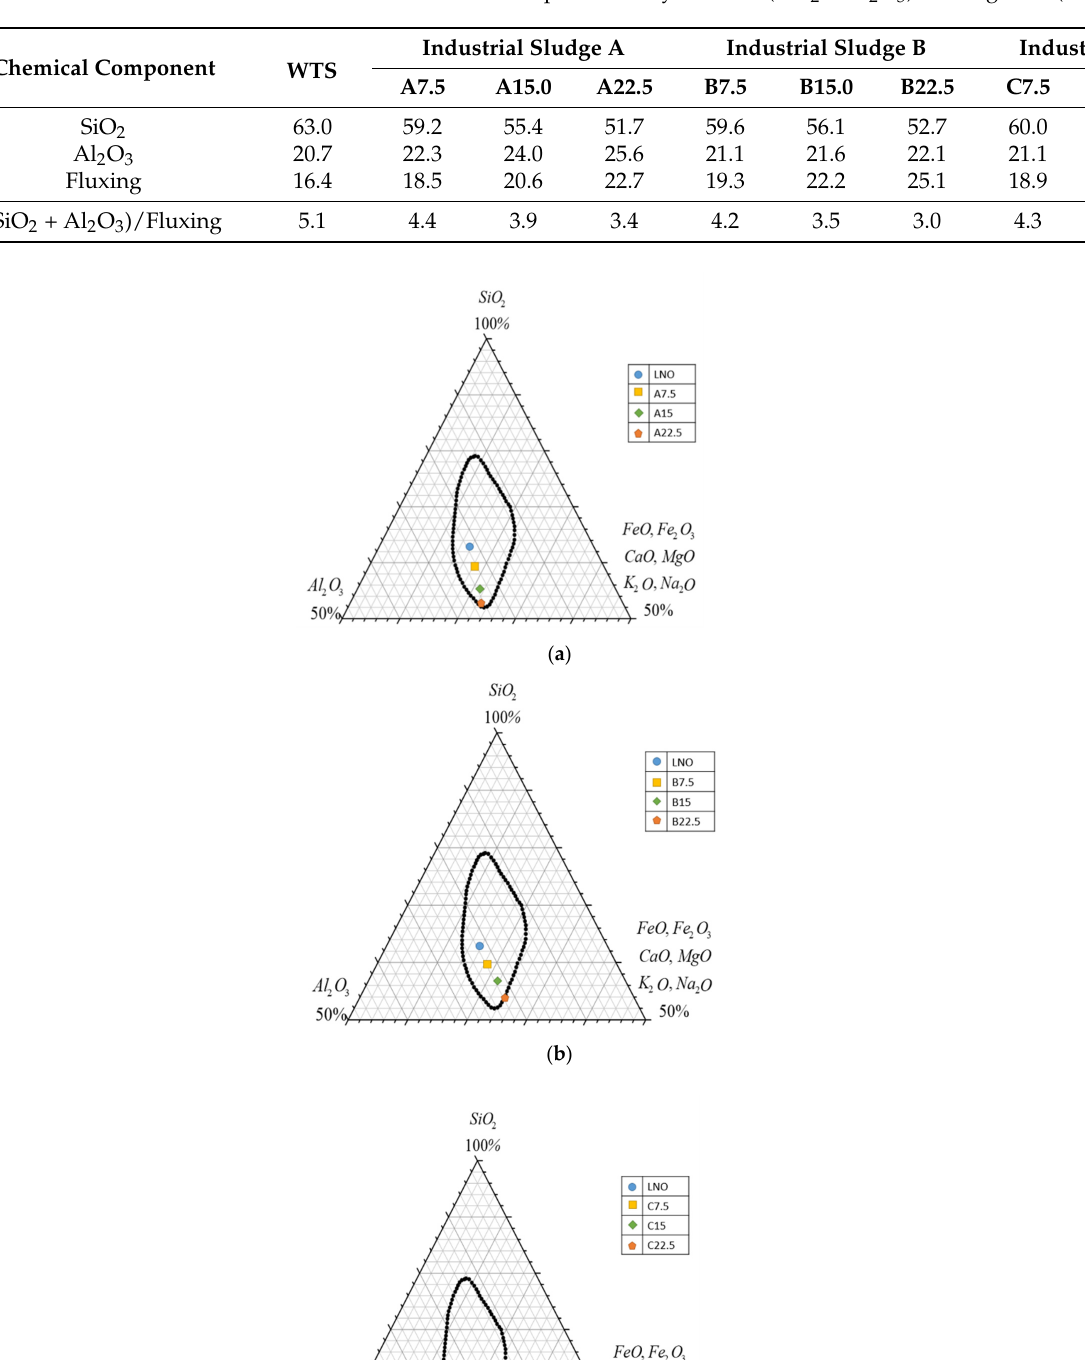
Table 5. The chemical component analysis of the (SiO 2 + Al 2 O 3 )/fluxing ratio (% by weight).